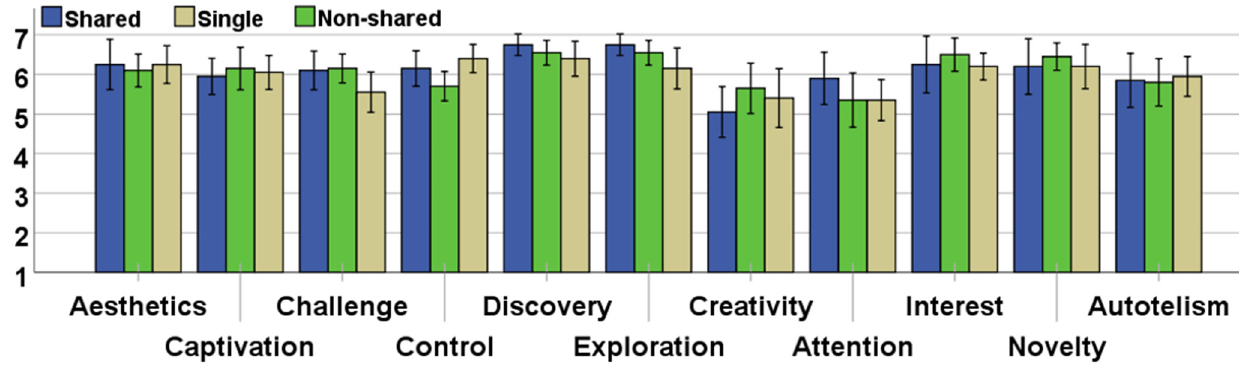
Figure 8. Engagement ratings on the 11 categories for Singles, Shared, and Non-Shared groups. Error bar indicates ± 2 standard errors.